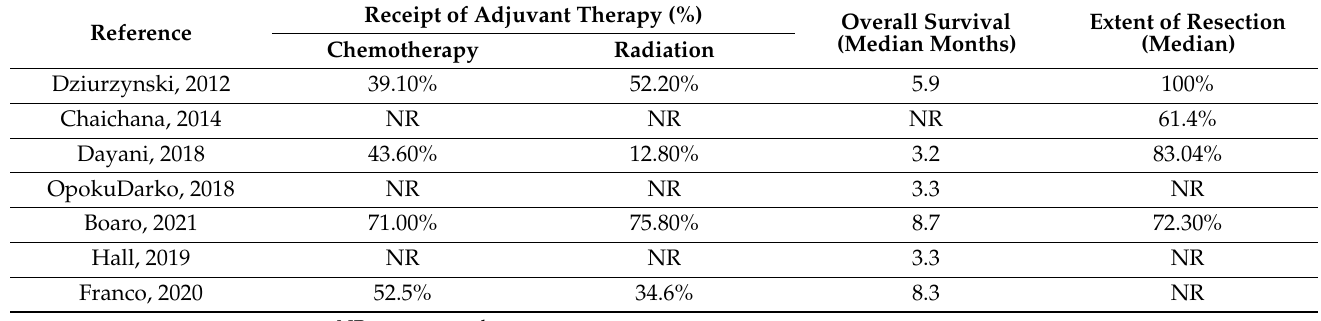
Table 3. Intervention and outcomes of included studies for all patients (surgery and biopsy).